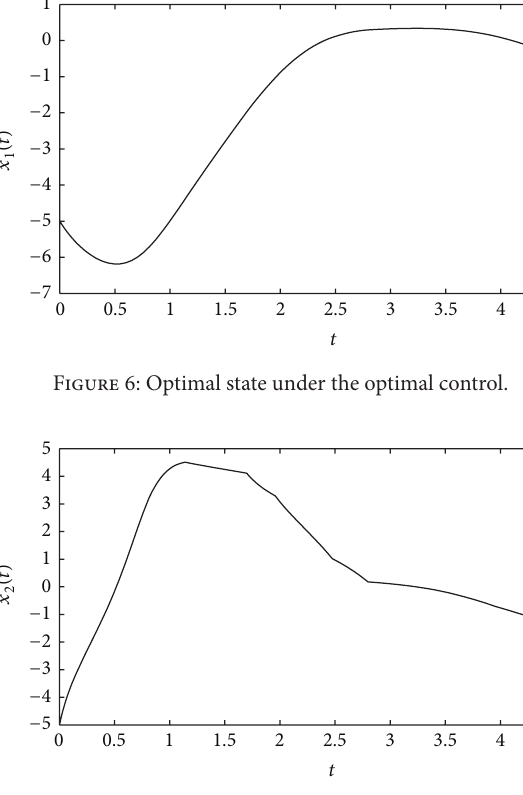
Figure 7: Optimal state under the optimal control.